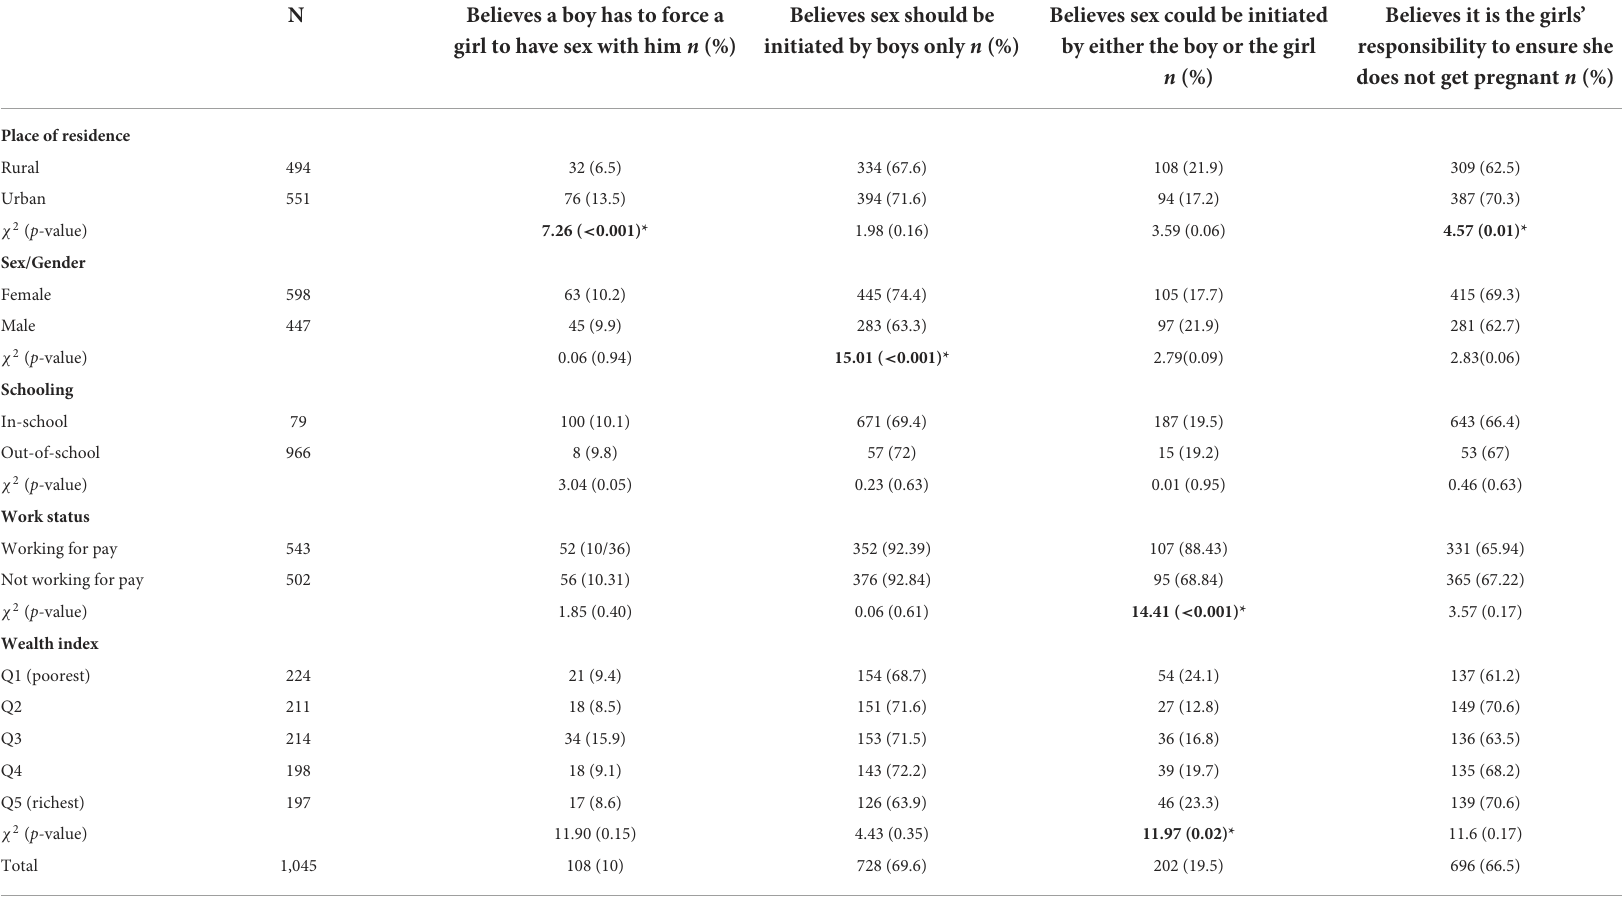
TABLE 4 Socio-demographic disaggregation of gender norms about adolescent sexuality. N Believes a boy has to force a girl to have sex with him n (%)